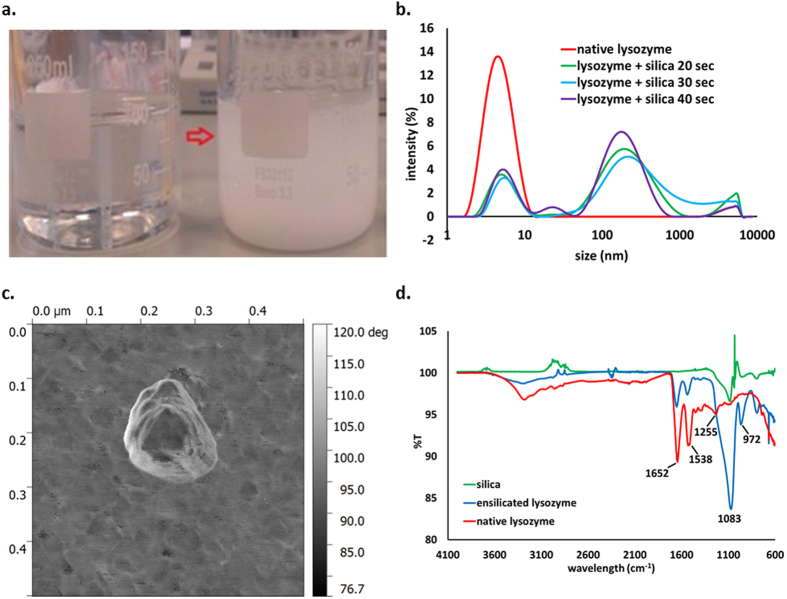
Formation of ensilicated powder.(a) Illustration of the ensilication. Left beaker contains protein solution, right beaker – protein solution with prehydrolysed TEOS after the formation of the silica precipitate. (b) DLS data for native lysozyme (red), and immediately after addition of TEOS (green – in 20 s, blue - in 30 s, purple – in 40 s). (c) AFM image of ensilicated lysozyme. (d) FT-IR spectra for native lysozyme (red), silica (green) and ensilicated lysozyme (blue). The bands at 1652, 1538, 1255 cm−1 correspond to amide I, amide II and amide III groups in lysozyme and the bands at 1063 and 972 cm−1 correspond to Si-O-Si stretching and Si-O bending.